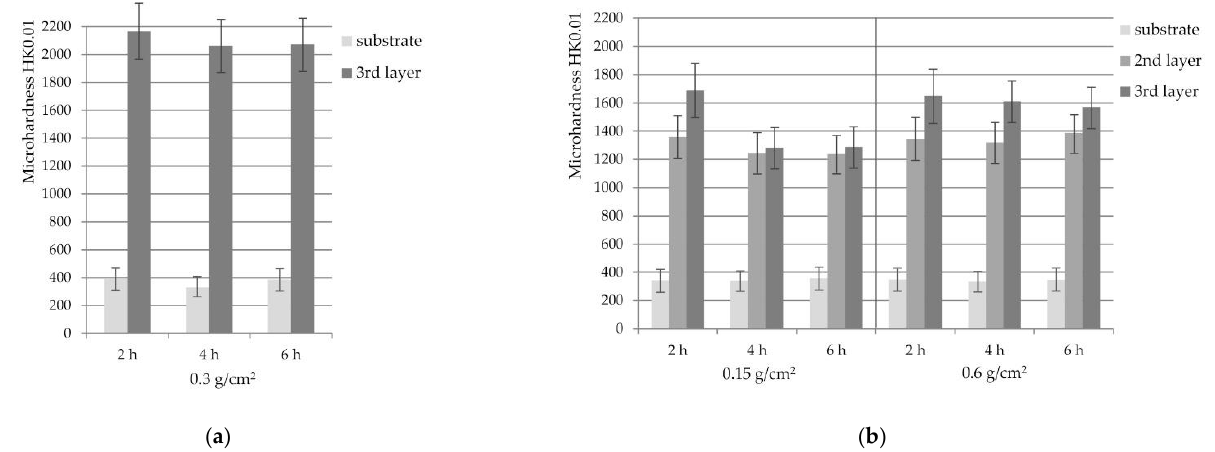
Figure 14. The results of the ( a ) Si and ( b ) Si-Al coating hardness measurements obtained on TZM alloy at 1000 °C for 0.15 and 0.6 g/cm 2 slurry volume and different time.